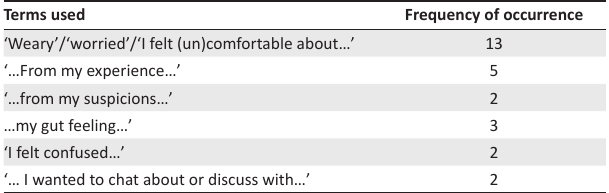
TABLE 1: Cognitive factors used and the frequency of